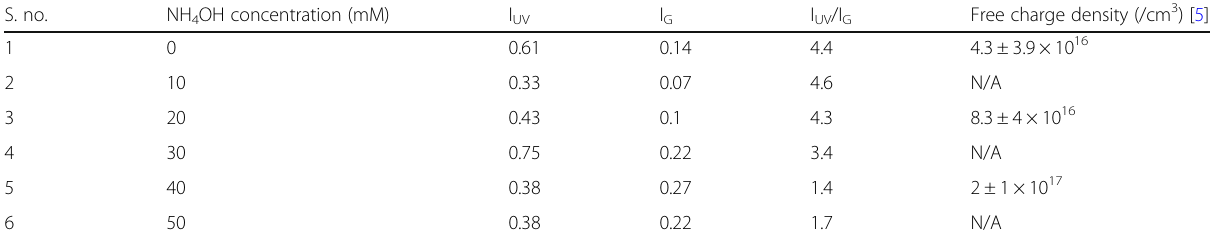
Table 2 Photoluminescence study of the influence of NH 4 OH addition over optical response of ZnO NWs S.